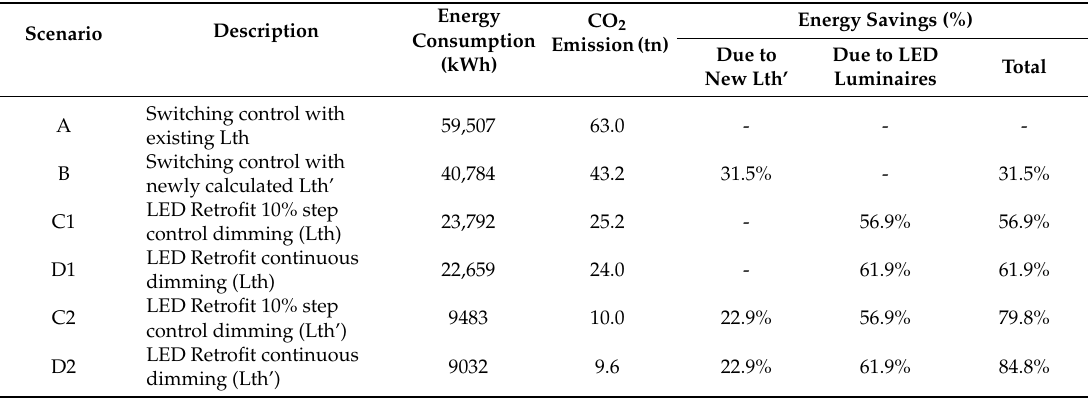
Table 12. Total energy consumption, annual CO 2 emission (using the emission factor 1058.95